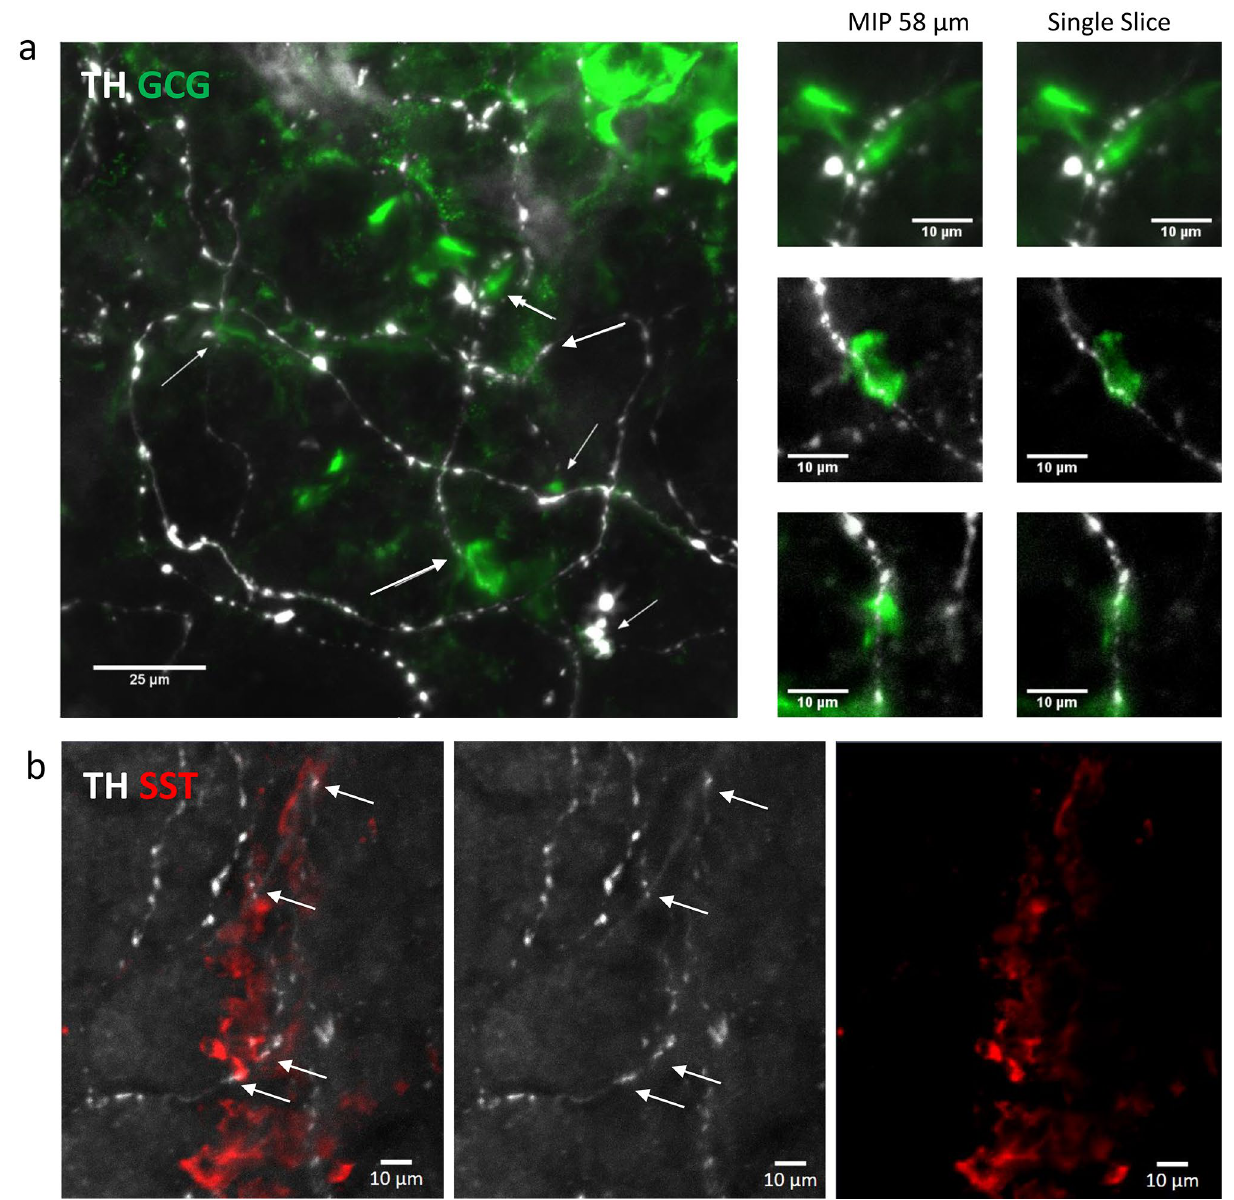
Figure 4. Islet α-cell and δ-cell proximity to TH varicosities in T1D. ( a ) Maximum project for human islet stained for TH (white) and GCG (green) in a T1D individual. TH axons in close proximity to α-cells are indicated by white arrows. Scale bar 25 µm. Insets for maximum intensity project (MIP, 58 µm stack) and single z slices for three regions in ( a ) are shown in higher detail. Scale bars 10 µm. ( b ) Maximum project for human islet stained for TH (white) and somatostatin (SST, red) in a T1D individual. A TH fiber coursing in close proximity to δ-cells (white arrows) is shown by merged and single channels. Scale bar 10 µm. See also Supplementary Videos